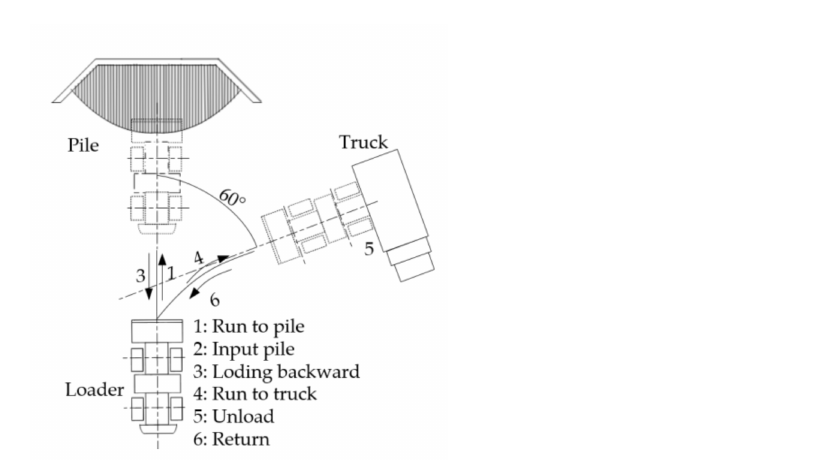
Figure 4. V-type duty cycle.